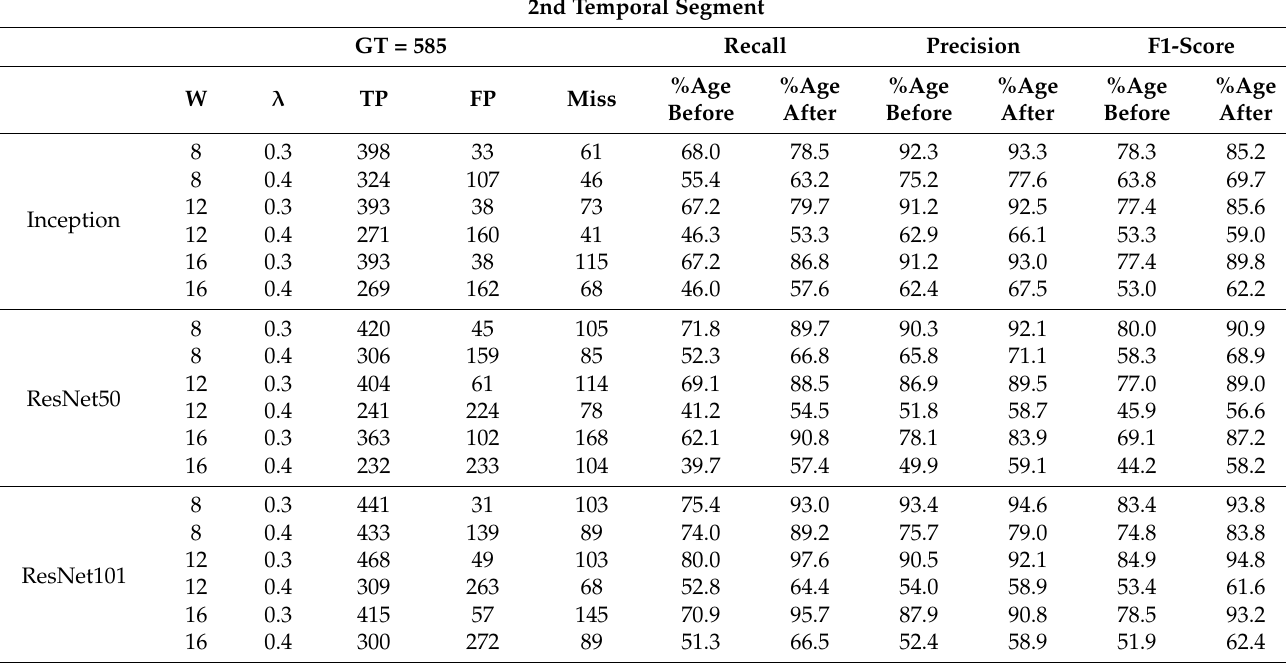
Table A3. Detections and refinement results of 2nd temporal segment.